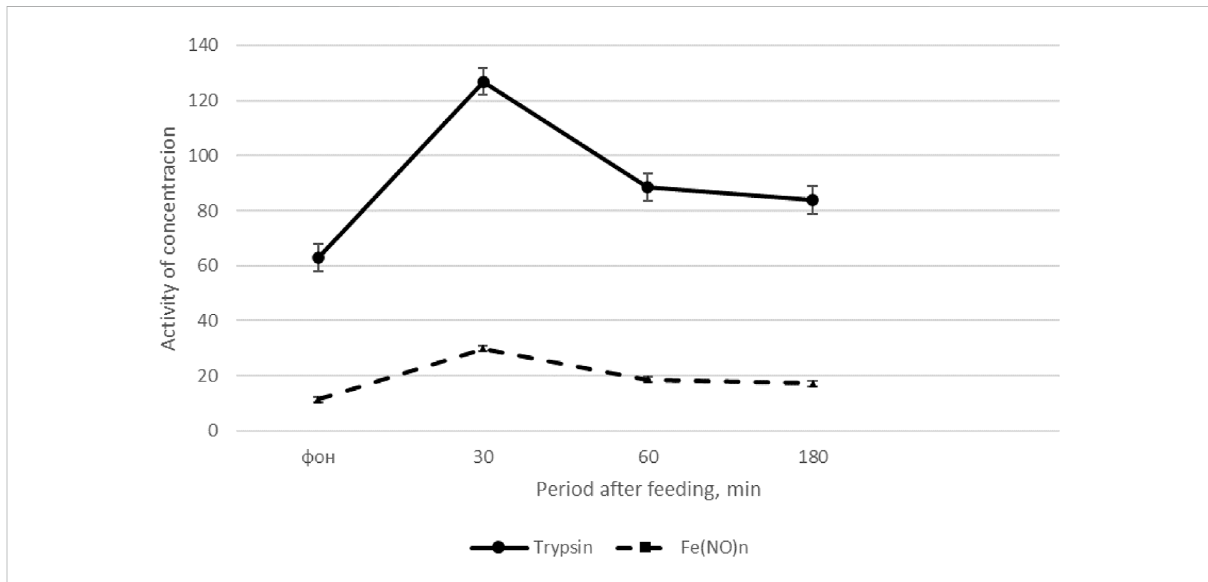
Dynamics of trypsin activity and the content of Fe(NO)n in cockerels after feeding (Fisinin V. I. et al.,